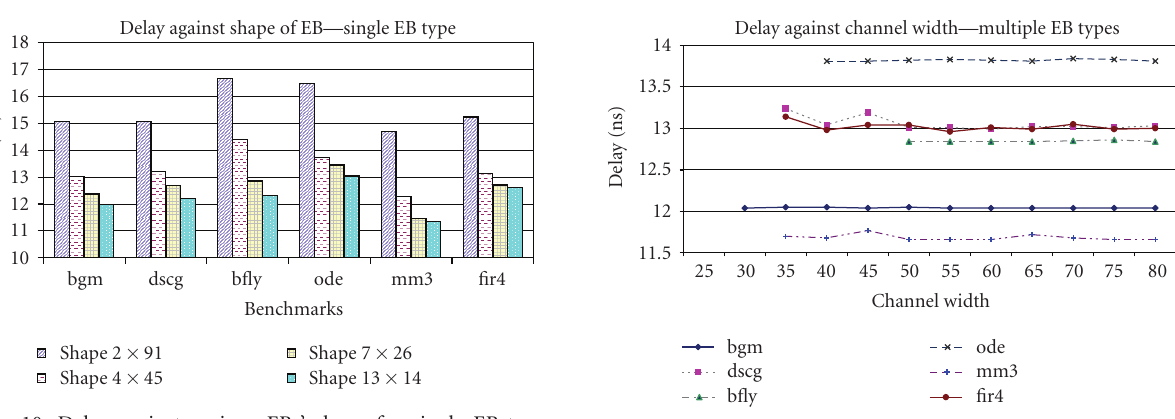
Figure 12: Delay against channel width for multiple EB types FPGA.